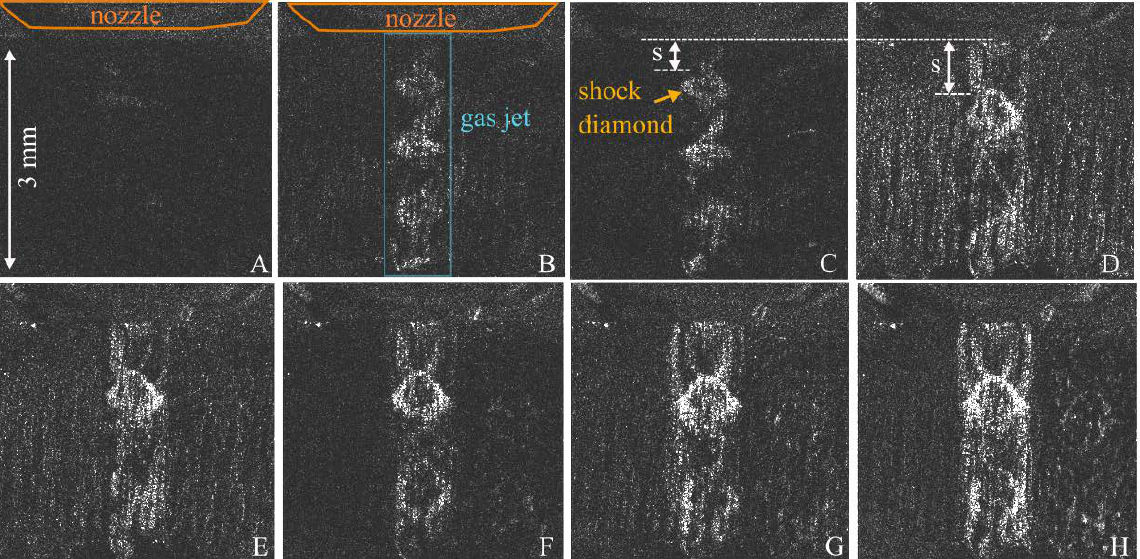
Figure 7. High-speed BOS imaging at the start of operation of the nozzle with a frame rate of 37,000 fps and an illumination time t = 0.5 µs. ( A ) The dark BOS image directly at the start of operation is shown. After the start of operation, fluctuations in the shock fronts are visible for about 30 ms ( B – G ), followed by a more steady appearance with the characteristic shock wave structure ( H ).